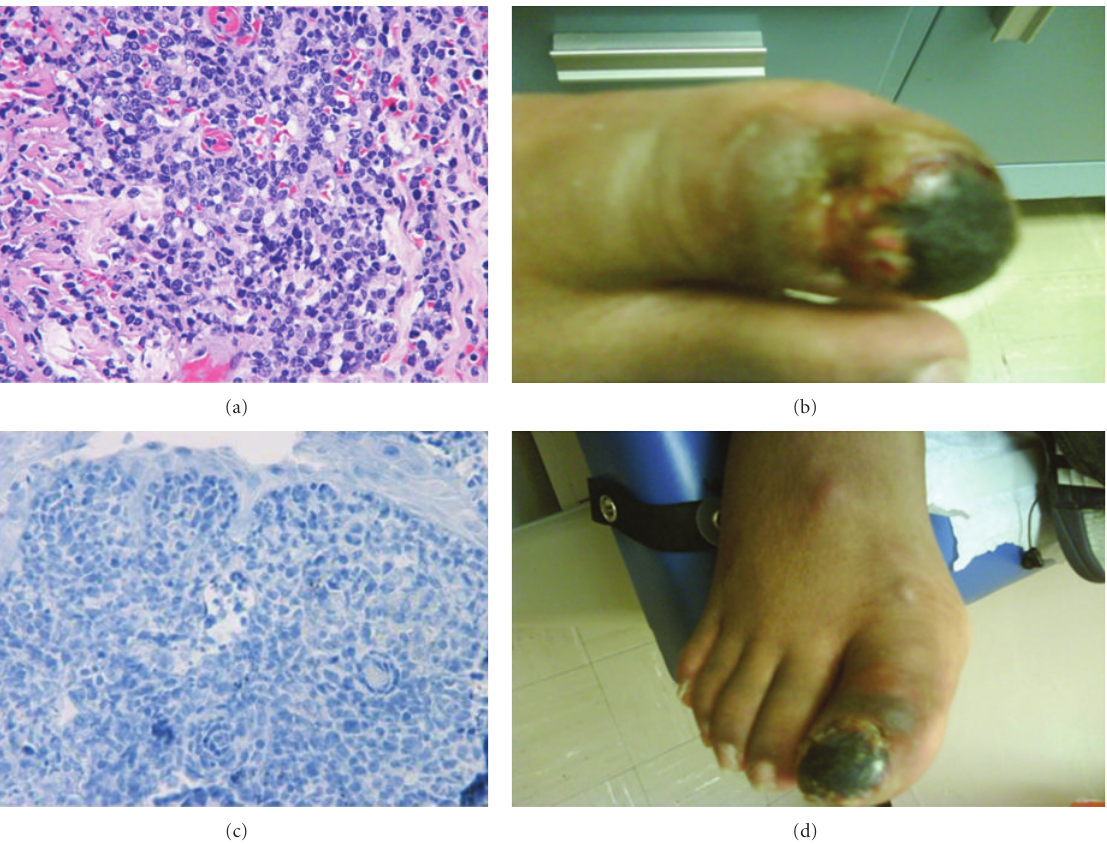
Figure 1: (a) Skin with dense lymphoid infiltrate, consisting of medium to large lymphocytes with dense chromatin, irregular nuclear contours, and occasional prominent nucleoli, shave biopsy (H&E, Original Magnification x400). (b) Patient at presentation with a single necrotic lesion on the big toe. (c) Immunostaining negative for NPM-ALK gene product (original magnification x400). (d) Multiple satellite lesions that appeared 3 weeks after initial